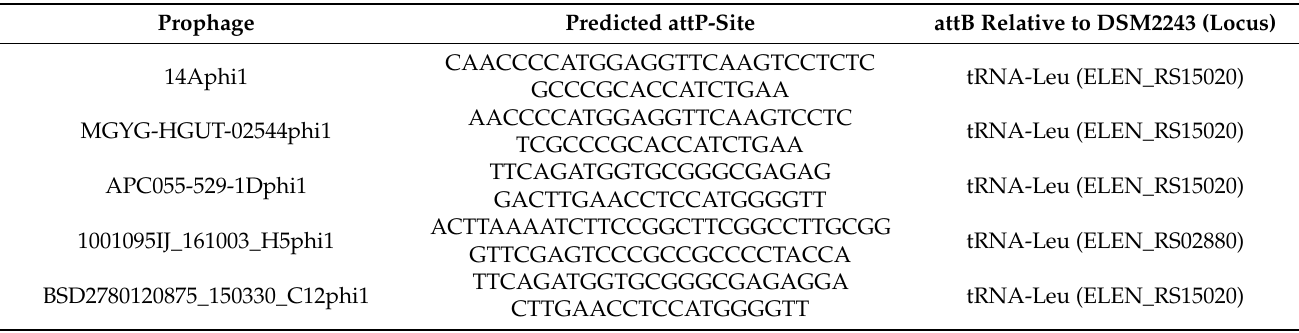
Table 3. Putative insertion sites among clade 1 E. lenta prophages.